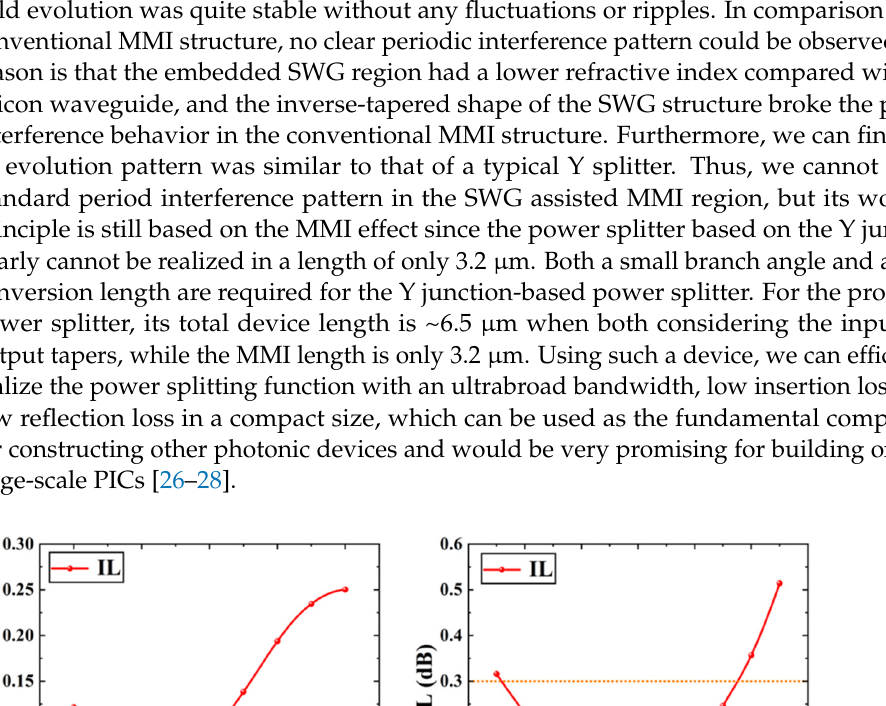
Figure 9. Fabrication tolerance analyses. IL dependence on ( a ) the width increment k of the inverse ‐ tapered SWG for the proposed device and ( b ) the grating size variation. A grating size of 100% corresponds to the optimum widths along the x ‐ and y ‐ directions. A grating size of 120% corre ‐ sponds to grating width increments relative to the optimum widths along the x ‐ and y ‐ directions. The horizontal line represents IL = 0.3 dB.